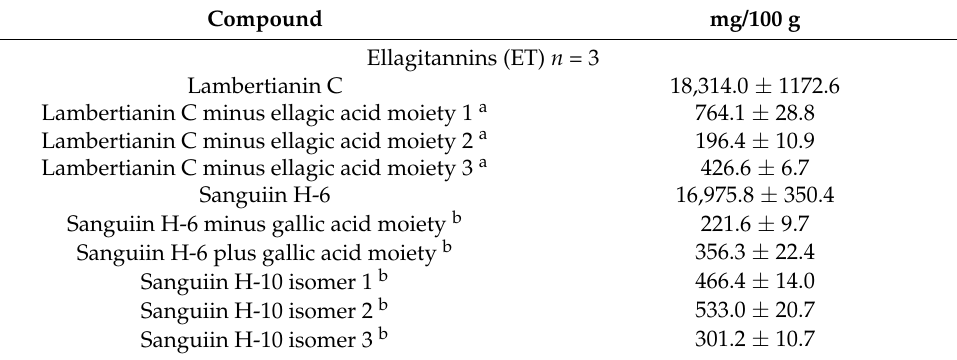
Table 1. Polyphenol composition of raspberry